Question: Does the plotted quantity increase or decrease?
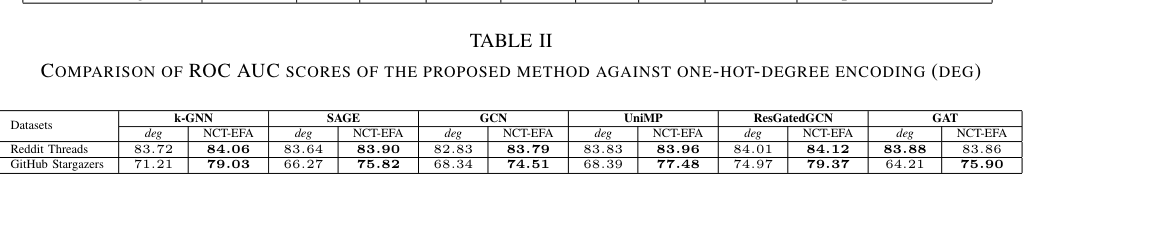
Answer: increasing